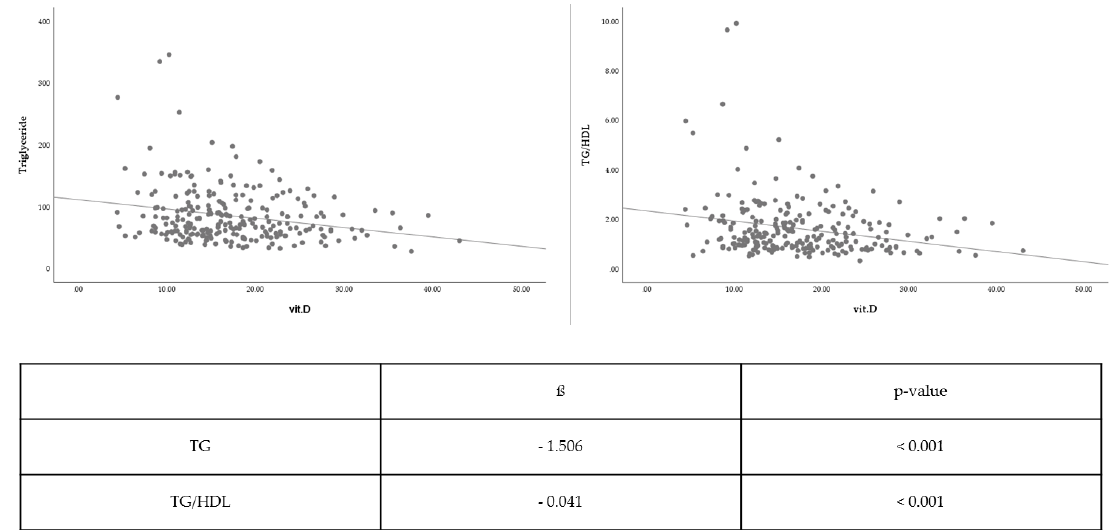
Figure 1. Association between the vitamin D levels and lipid profiles. TG/HDL: Triglyceride to high-density lipoprotein, vit.: Vitamin.